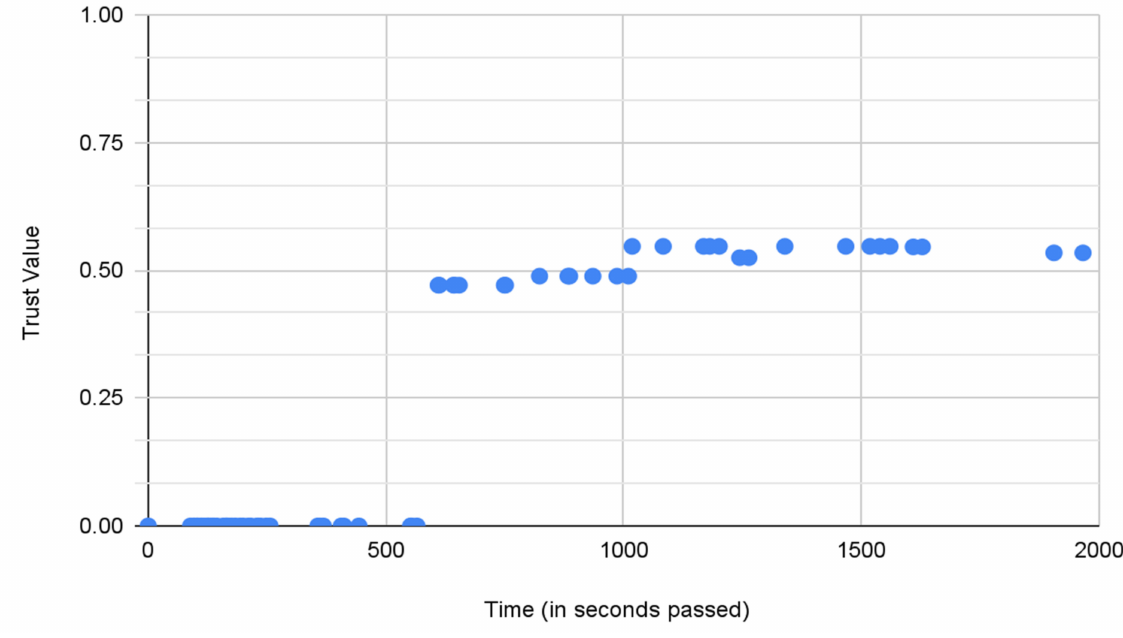
Figure 14. Scatter plot of the time series of 0.5 quantiles from the